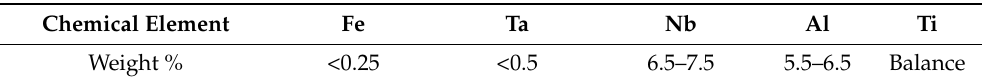
Table 1. Chemical composition of the Ti-6Al-7Nb